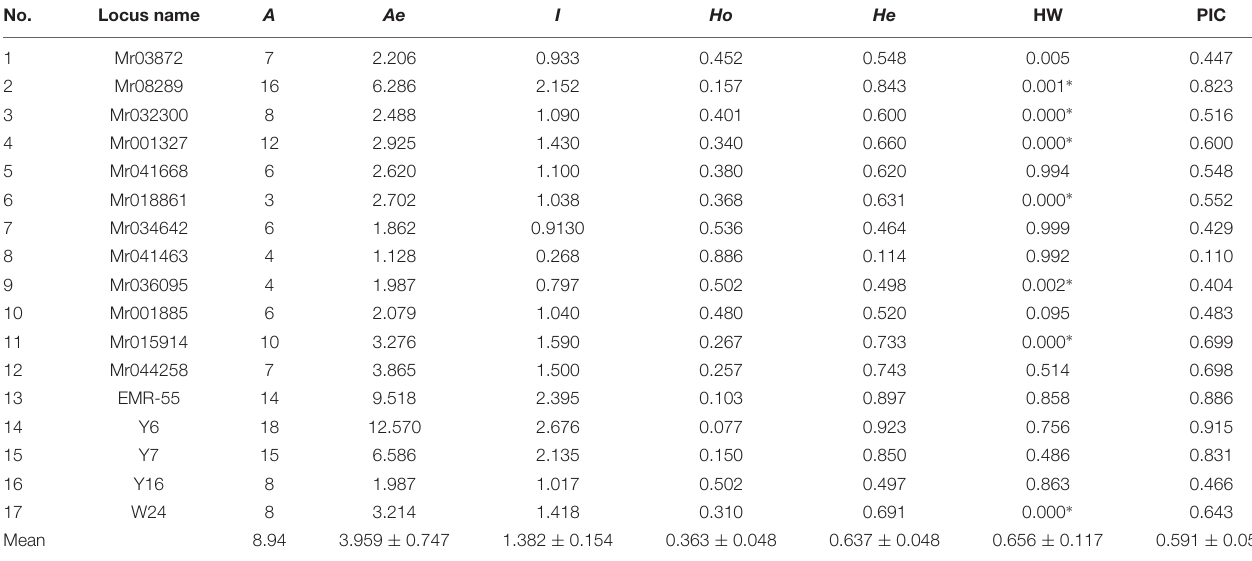
TABLE 3 | Genetic variability at eighteen microsatellite loci in seven populations of M. rosenbergii . No.